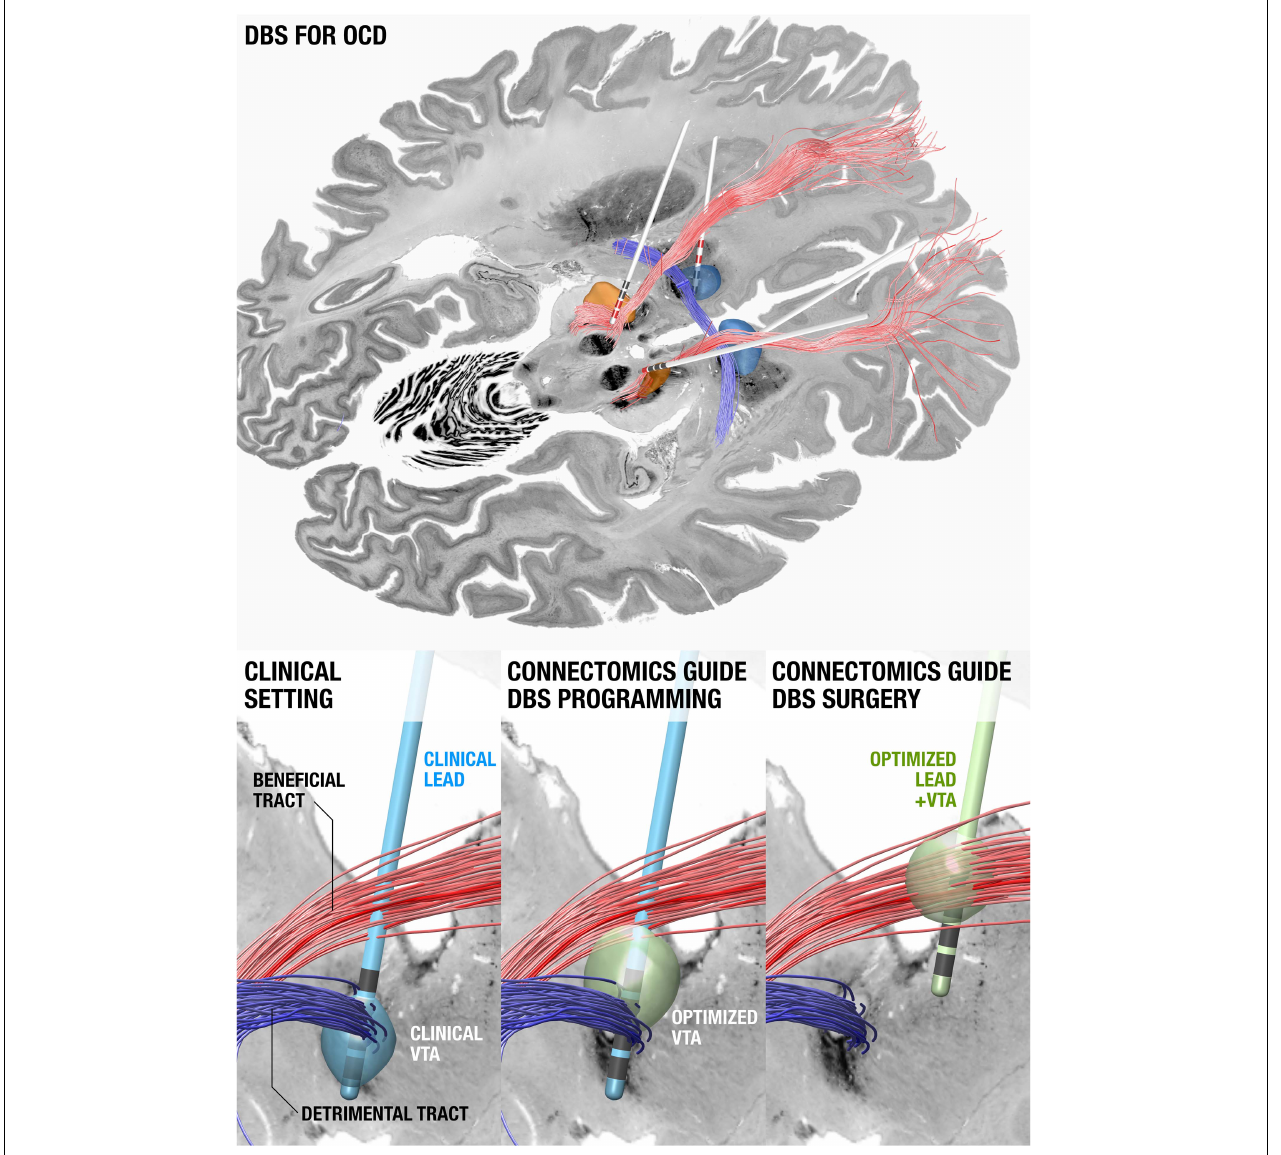
FIGURE 4 | Using connectomics to guide surgery and DBS programming. (Top) DBS tract filtering. Four DBS electrodes implanted to the anteromedial subthalamic nucleus and anterior limb of the internal capsule in a patient with obsessive compulsive disorder. Active contacts are marked in red. A tract associated with optimal clinical improvement across 50 patients (limbic hyperdirect pathway within the anterior limb of the internal capsule) is shown in red, one associated with poor improvement (posterior limb of the anterior commissure) in blue. (Bottom left) Clinical DBS setting. (Bottom middle) Upon further confirmation of results, based on the existing electrode and the connectomic information, the stimulation settings could be optimized. (Bottom right) In novel patients, both surgical targeting and DBS programming could potentially be optimized. Data from Li et al. (2020), background slices show the BigBrain dataset (Amunts et al., 2013) after precise